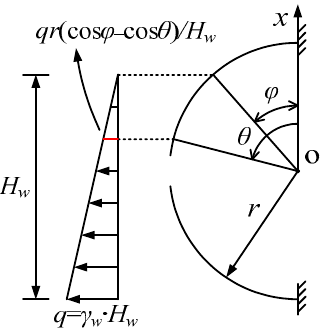
Figure 5. Load diagram of the water level at the upper part of the tunnel.